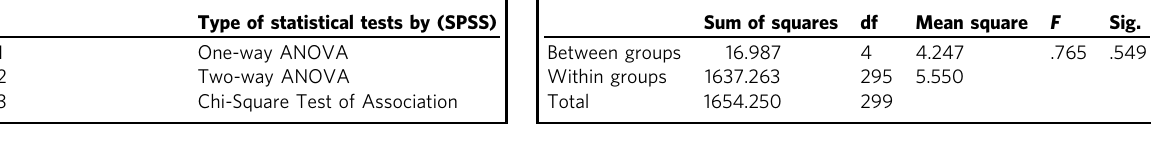
Table 3 ANOVA Undermine gatekeeping